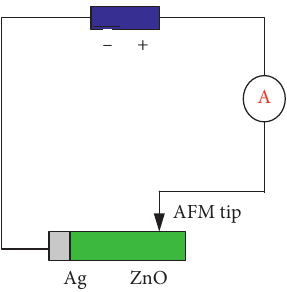
Figure 4: Planar form of conducting process of nano ZnO valve sheet.